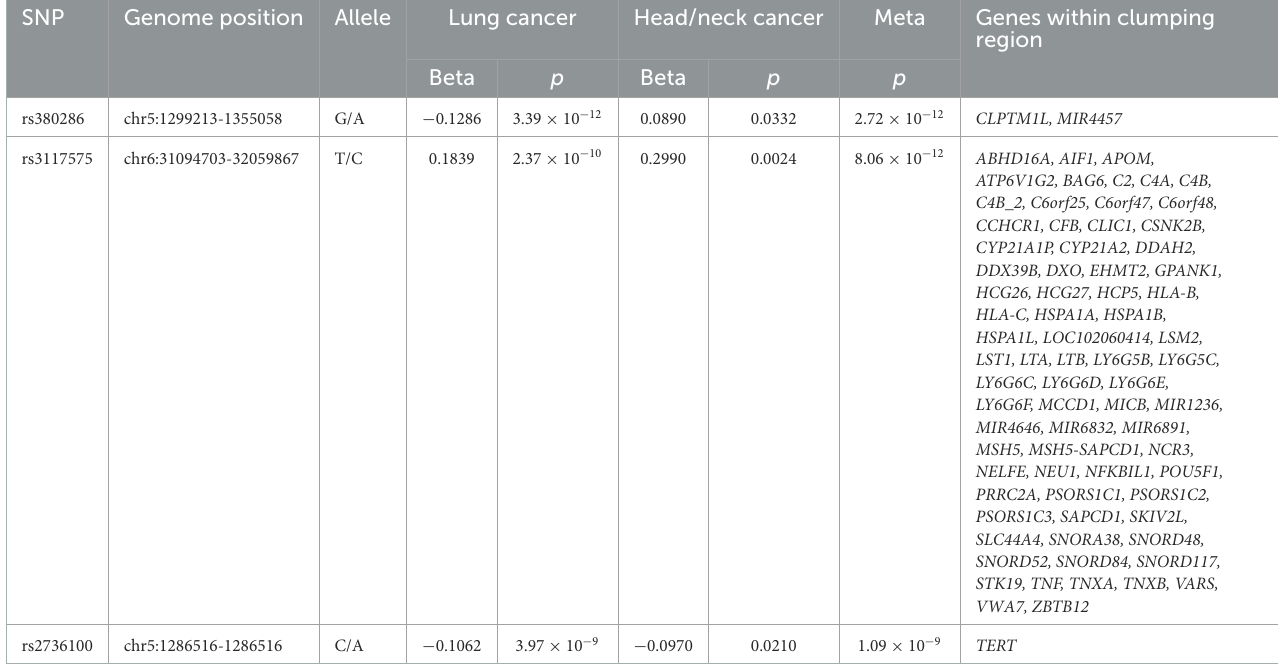
TABLE 4 Cross-trait meta-analysis result between the lung and head/neck cancers ( p meta < 5 × 10 − 8 ; single-trait p < 0.05). SNP Genome position